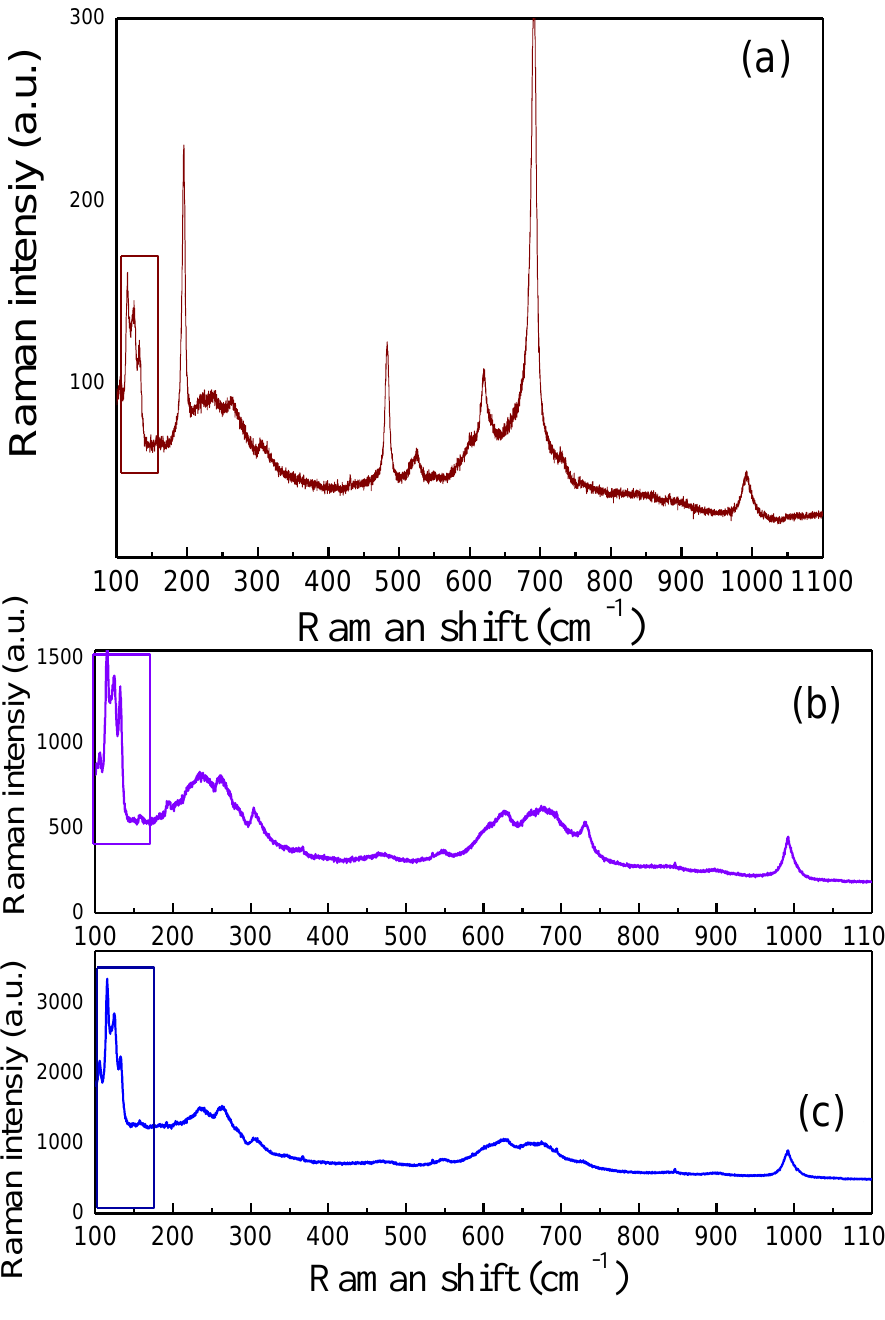
Figure 2. Raman spectra of the catalysts: ( a ) CoMo/Nb 2 O 5 , ( b ) PtMo/Nb 2 O 5 , and ( c ) NiMo/Nb 2 O 5.